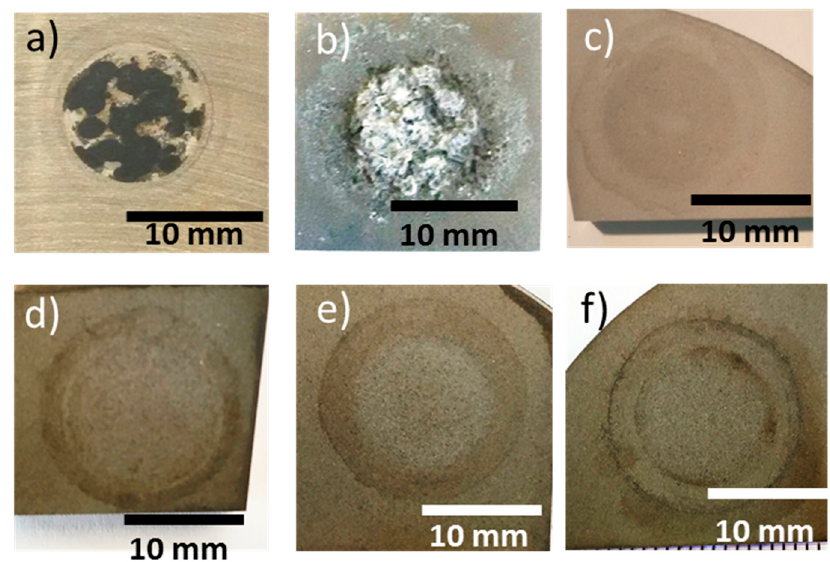
Figure 13. Plan view macrographs of the different coatings after the anodic-cathodic corrosion tests (scales in mm) ( a ) uncoated substrate and the different coated samples ( b ) 1L-1, ( c ) 2L-1, ( d ) 2L-2, ( e ) 2L-3, and ( f ) 2L-4.